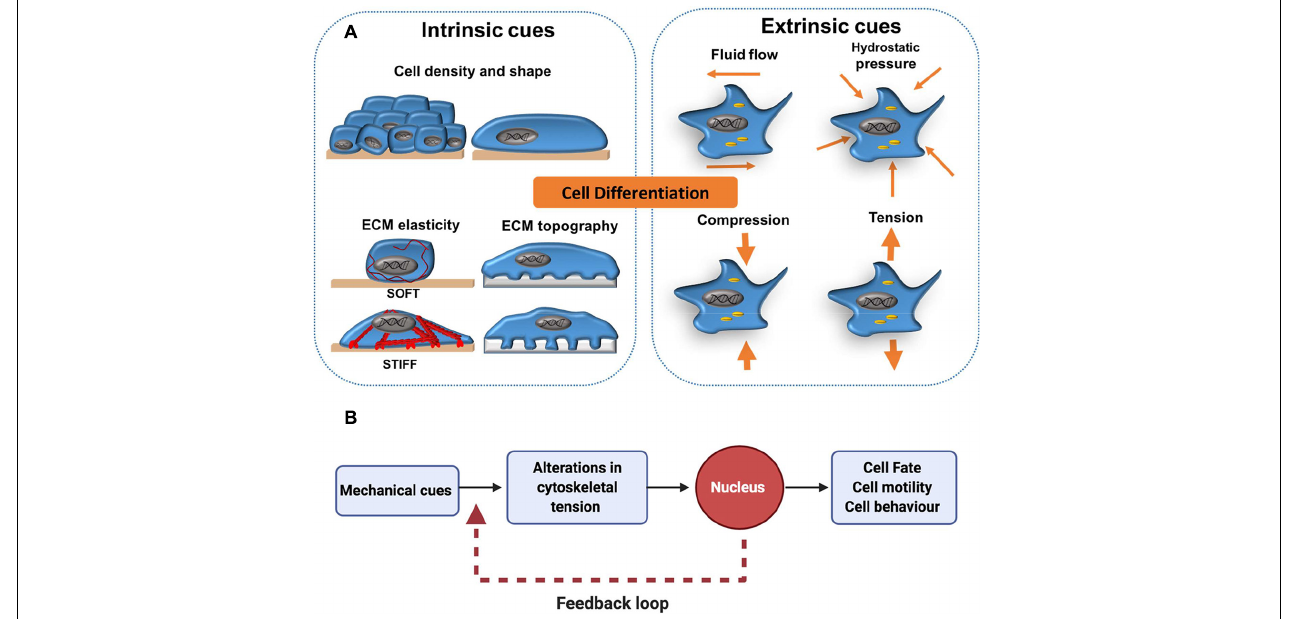
FIGURE 1 | Extrinsic and intrinsic cues in mechanotransduction. (A) Cell differentiation has been shown to be affected by mechanical forces external to the cell (extrinsic) such as shear stress from fluid flow and more local mechanical cues (intrinsic) such as cell density, shape and elasticity of the surrounding extracellular matrix (ECM). (B) As a general concept, mechano-transduction involves the transfer of mechanical cues from the cell surface to the nucleus via the cytoskeleton. This activates downstream cell signalling cascades, which can influence cell fate decisions. In addition, a transcriptional feedback loop allows cells to maintain a cytoskeletal equilibrium that is responsive to changes in their mechano-environment. This is particularly important for processes like cell migration, in which continual cytoskeletal remodelling is required for persistent cell motility.